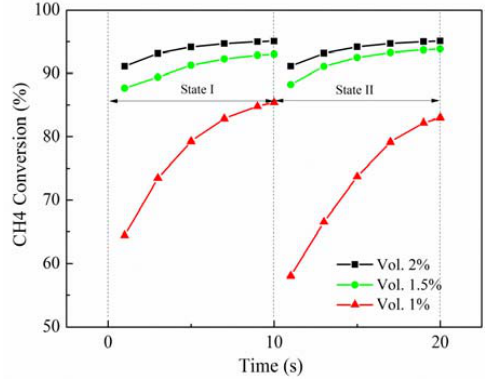
Figure 6. The effect of concentrations on the methane conversion rate. v = 20 m/s.